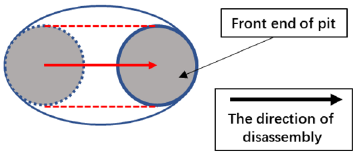
Figure 9 The movement trend of the particle in the texture